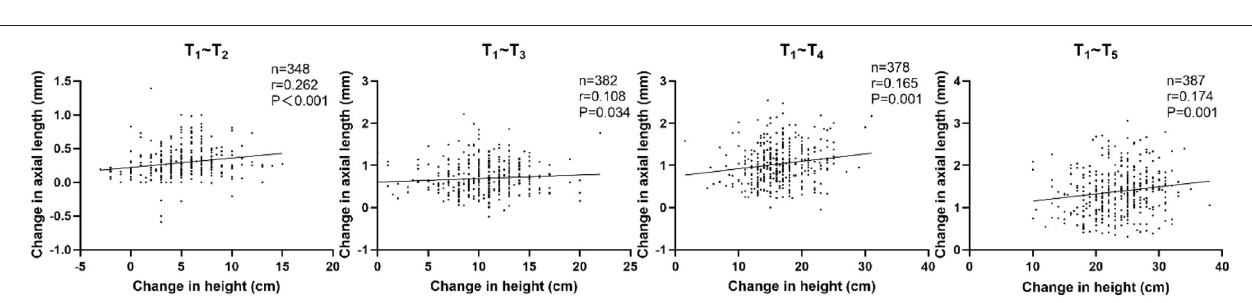
FIGURE 2 | Correlation between height and axial length in the newly developed myopia group.